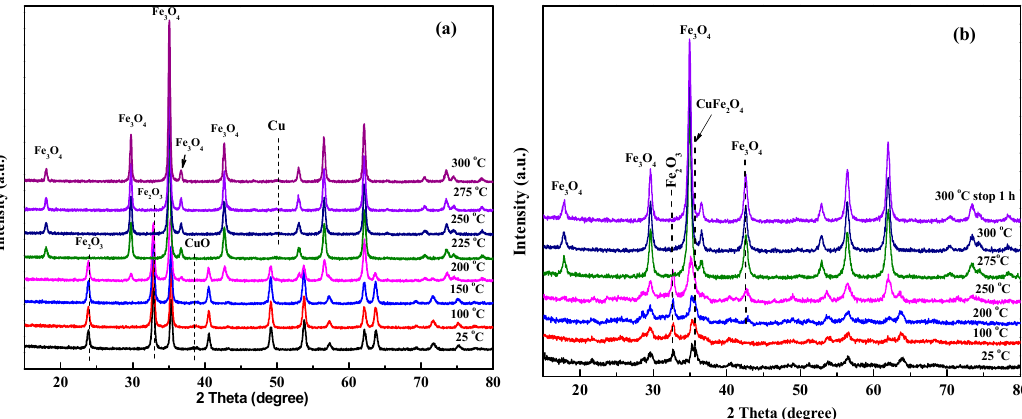
Figure 4. In-situ XRD patterns of CuFe19-P ( a ) and CuFe19-R ( b ) reduced at different Figure 4. In ‐ situ XRD patterns of CuFe19 ‐ P ( a ) and CuFe19 ‐ R ( b ) reduced at different temperatures.